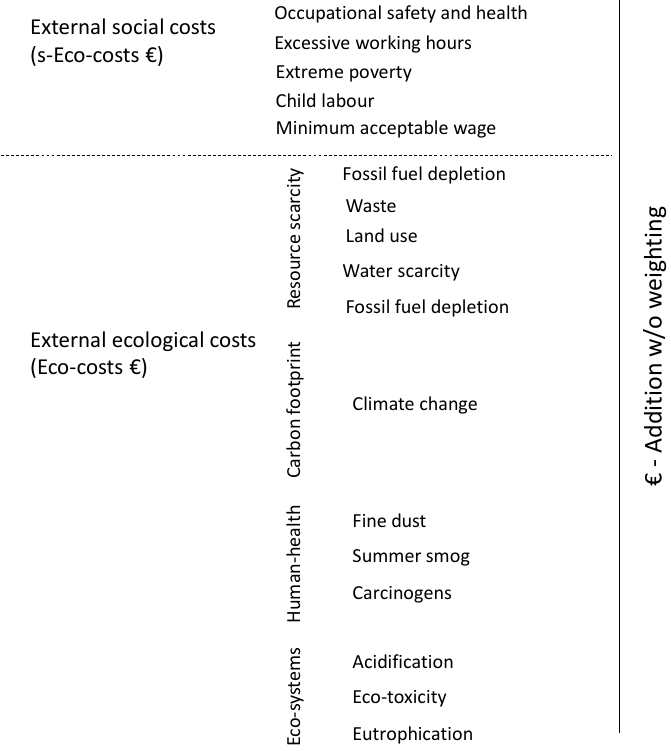
Figure 5. Social hotspot identification of a t-shirt supply chain using selected s-LCA indicators from the PSILCA database (own drawing from [38]).